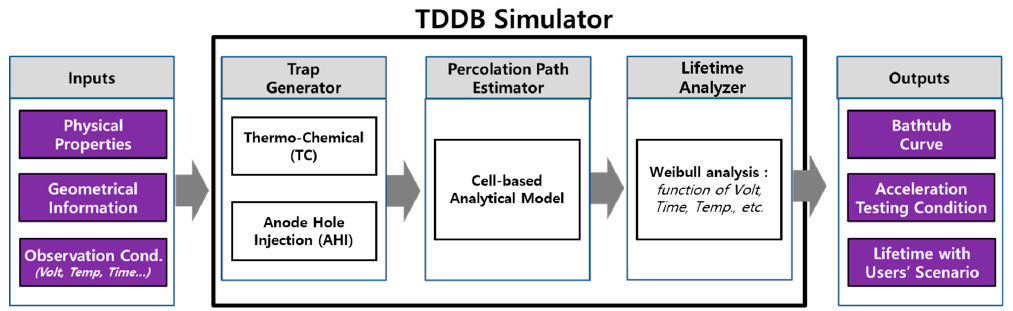
Figure 2. Description of the proposed TDDB hybrid model with one input, one output, and three core modules for TDDB analysis.